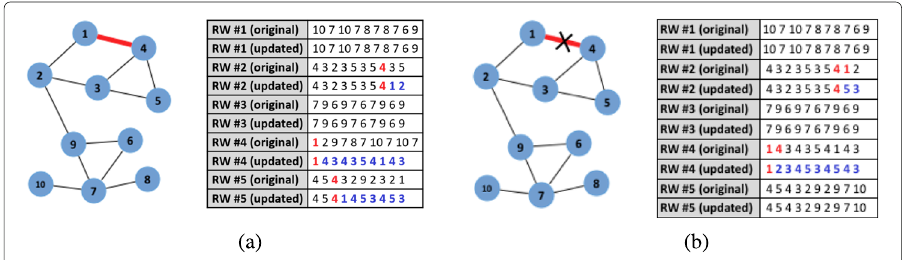
Fig. 2 Illustrative example of E VO NRL updates for edge addition and edge deletion (colored). a Example addition of a new edge (1;4). Random walks in reserve need to be updated to adhere to the change in the network topology. Our method guarantees that the new edge is equally represented in the updated set of random walks. b Example deletion of an existing edge (1;4). Random walks in reserve need to be updated to adhere to the change in the network topology. In this example, random walk #2 and #4 traverse edge (1;4) and need to be